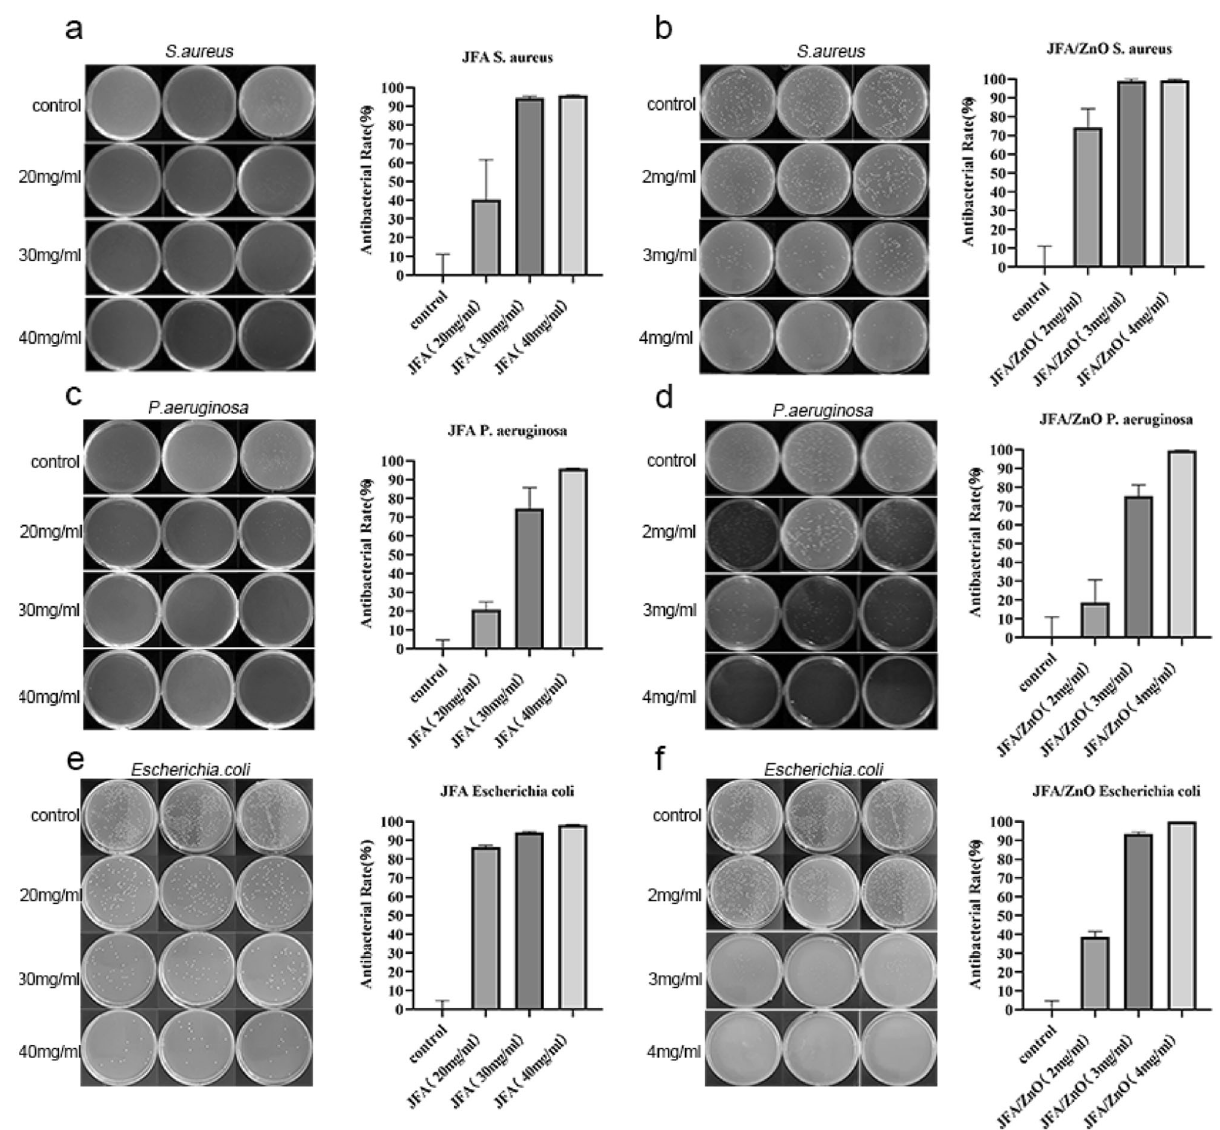
Fig. 4 a Growth diagram for the antibacterial capacity of JFA soaking solution against S. aureus at concentrations of 20 mg/mL, 30 mg/mL and 40 mg/mL; b growth diagram for the antibacterial capacity of 2 mg/mL, 3 mg/mL and 4 mg/mL ZnO/JFA immersion solution against S. aureus ; c growth diagram for the antibacterial capacity of 20 mg/mL, 30 mg/mL and 40 mg/mL JFA immersion solution against P. aeruginosa ; d growth diagram for the antibacterial capacity of